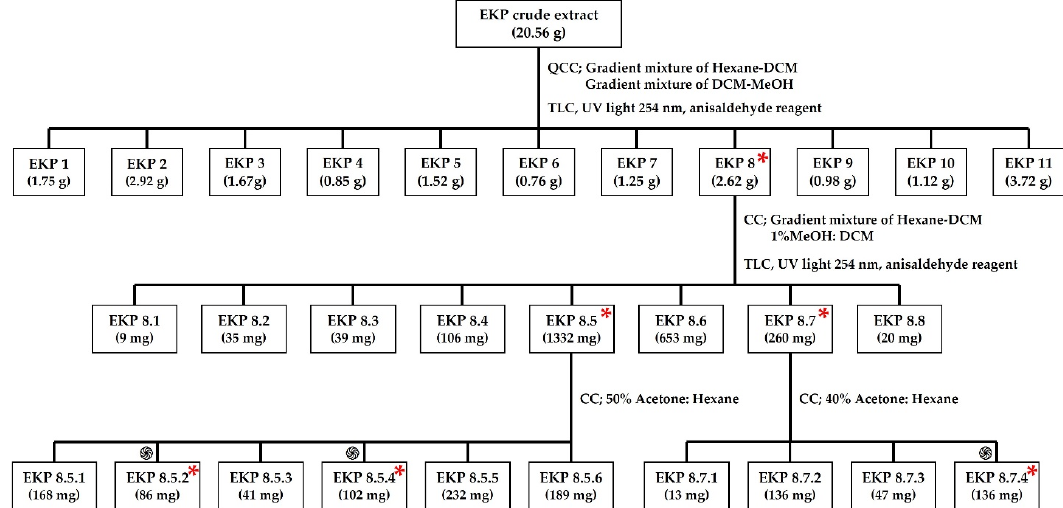
Figure 2. Flow chart presenting the sequential processes for the purification of ethanolic Kaempferia parviflora extract (EKP) as described in section 4.3 in Materials and Methods. Red asterisk (*) indicates the selected EKP that possessed the strongest antibacterial activities (against the tested bacterial strains) in each step of purification. EKP = Ethanolic extract of K. parviflora . EKP 8.5.2 = 3,5,7-trimethoxyflavone, EKP 8.5.4 = 3,5,7,3’,4´-pentamethoxyflavone, and EKP 8.7.4 = 5,7,4´-trimethoxyflavone. QCC = Quick column chromatography, CC = Column chromatography, TLC = Thin layer chromatography, UV = Ultraviolet, DCM = Dichloromethane, MeOH = Methanol, and ֍ = Recrystallization.